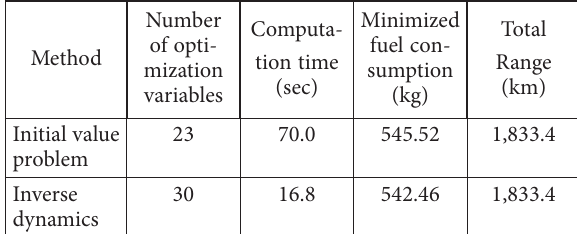
Table 1. Optimization results of initial value problem and inverse dynamics